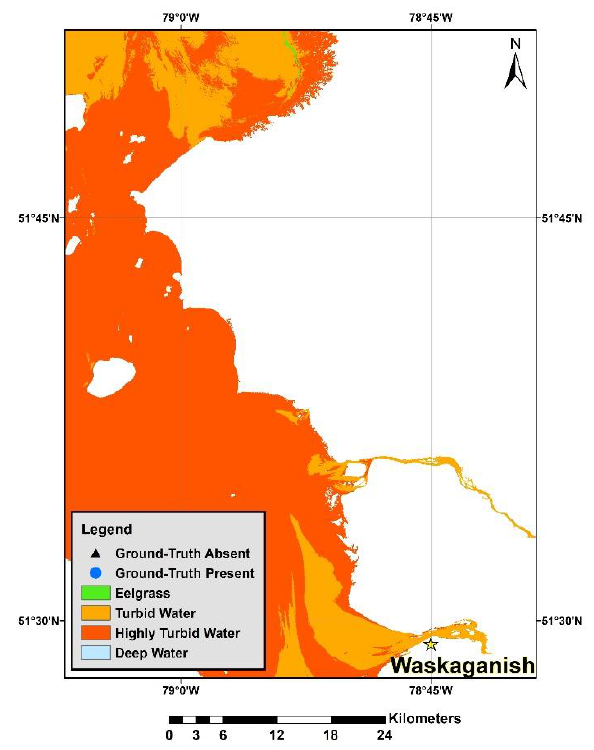
Figure 11. Classified image produced by applying the Random Forests classifier to both Landsat-8 OLI images outlining the coastline around Waskaganish.